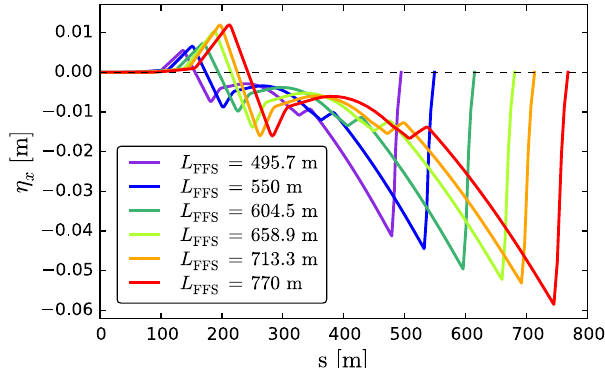
FIG. 21. Dispersion profile for different FFS lengths with L (cid:1) ¼ 6 m.